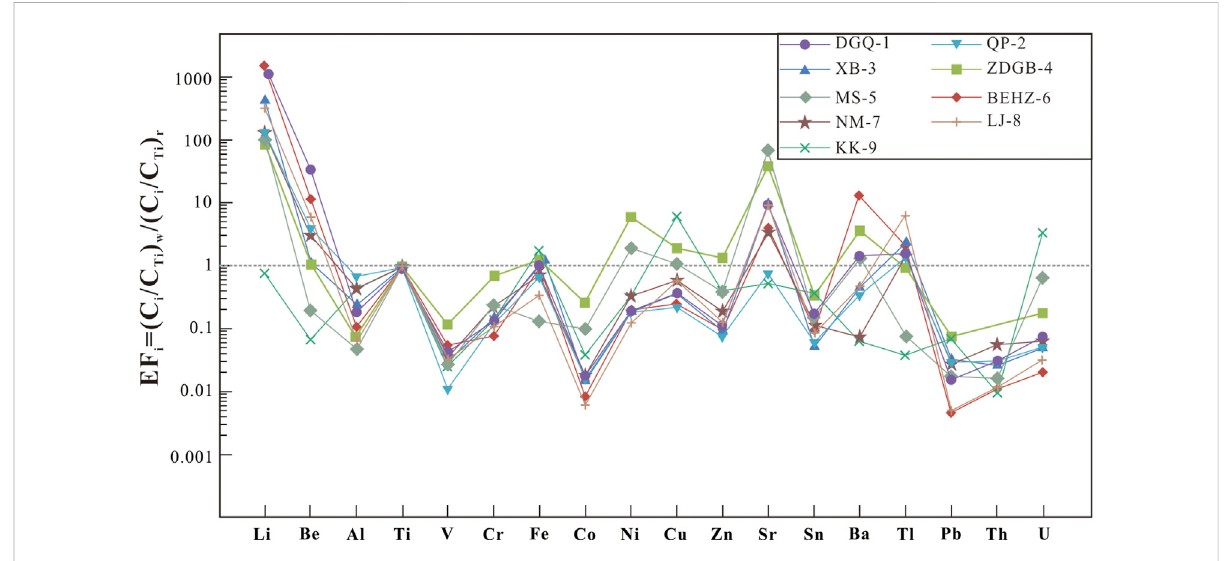
FIGURE 4 Trace element distribution for geothermal water samples along the